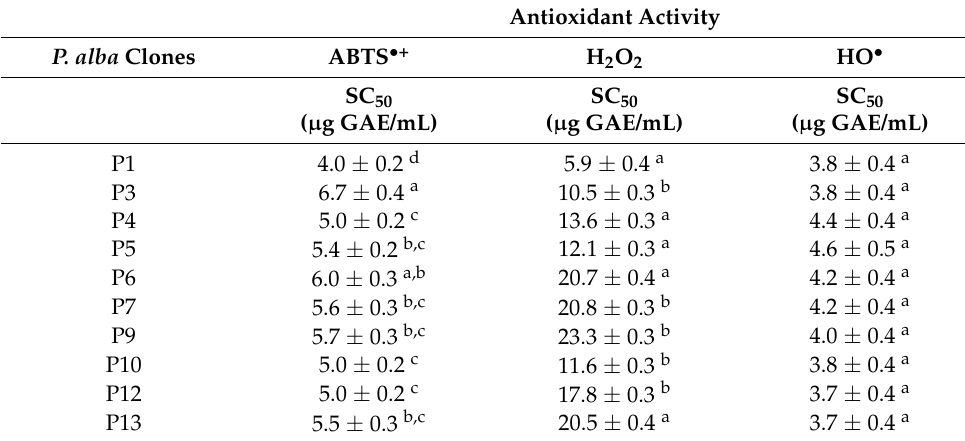
Antioxidant Activity